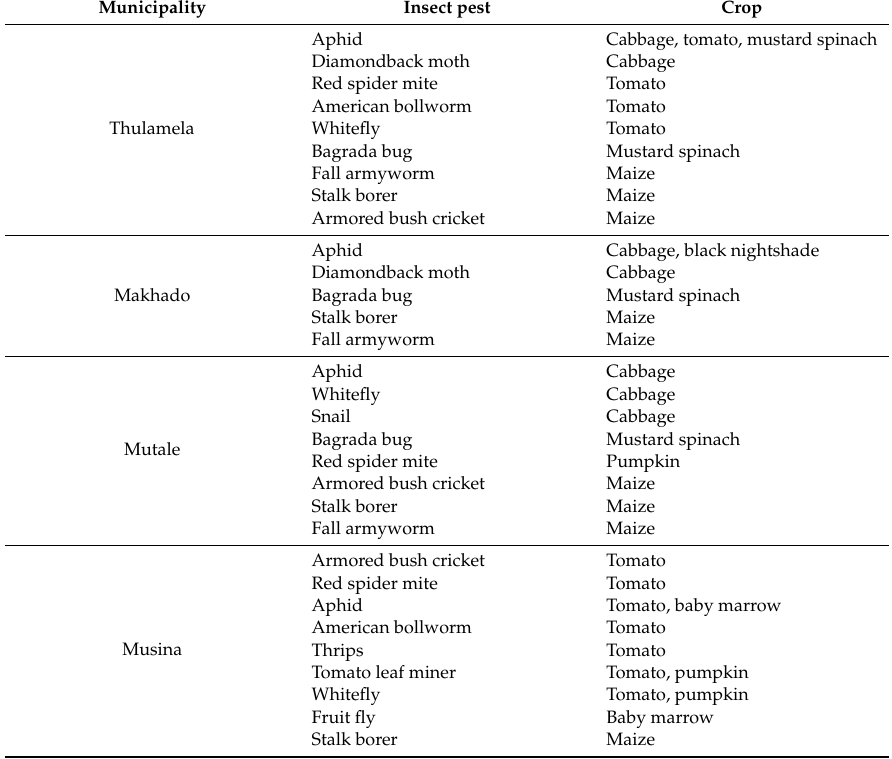
Table 4. Perception of the problematic insect pests across municipalities mentioned by key